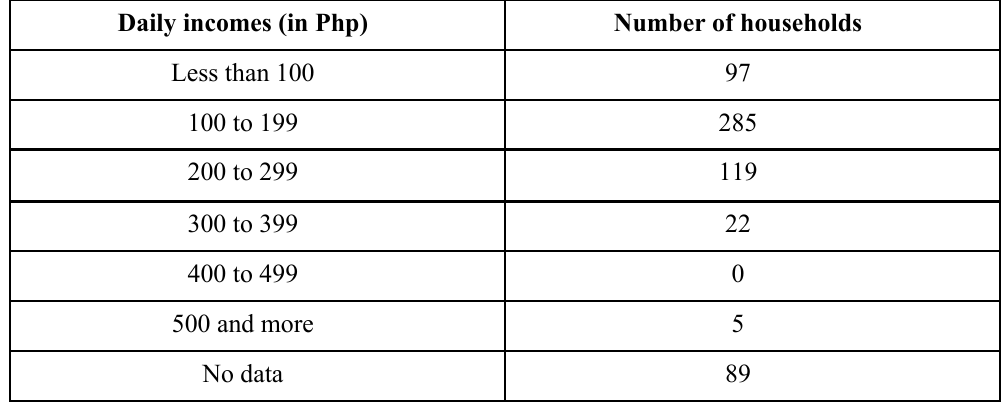
Source: Data from Quezon City Social Services Development Department – Note: 45 php =